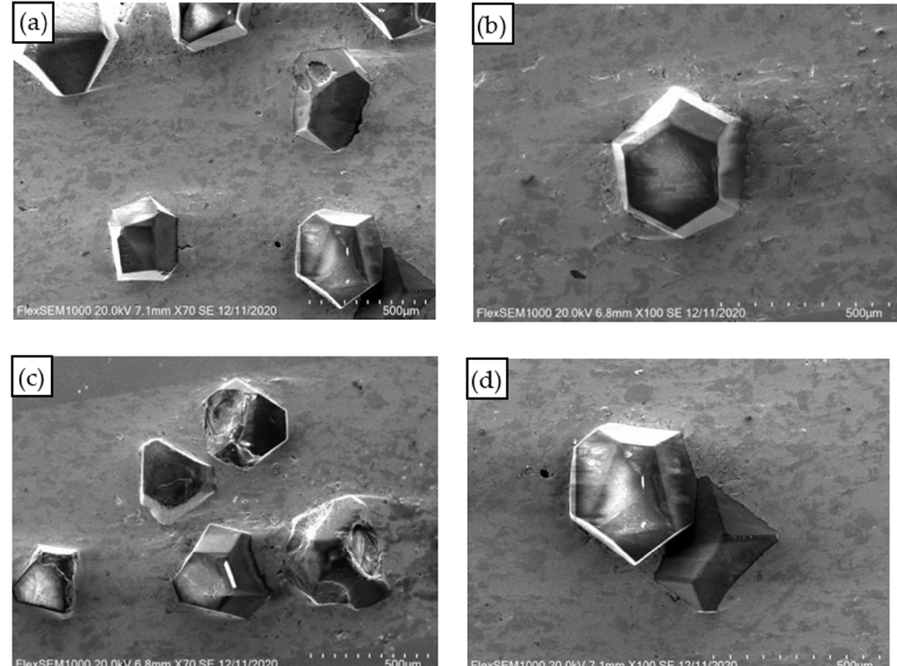
Figure 3. The distribution of diamond particles in the copper matrix. ( a ) High volume distribution; ( b ) Low volume distribution; ( c ) Fragmentation of diamond particles; ( d ) Diamond particle buildup.